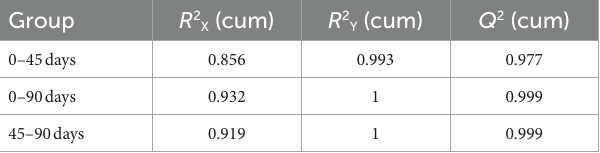
TABLE 2 Parameters of the OPLS − DA models for LSCKs fermented for 0, 45, and 90 days.